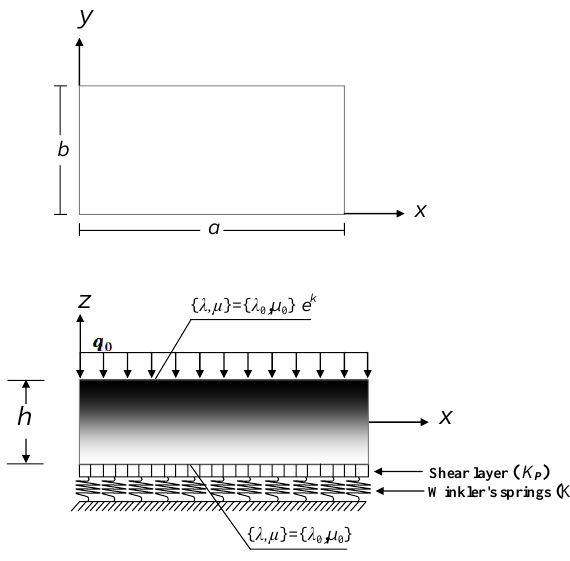
Figure 1. Coordinate system and geometry of the EG thick rectangular plate resting Figure 1: Coordinate system and geometry of the EG thick rectangu- on elastic foundations. lar plate resting on elastic